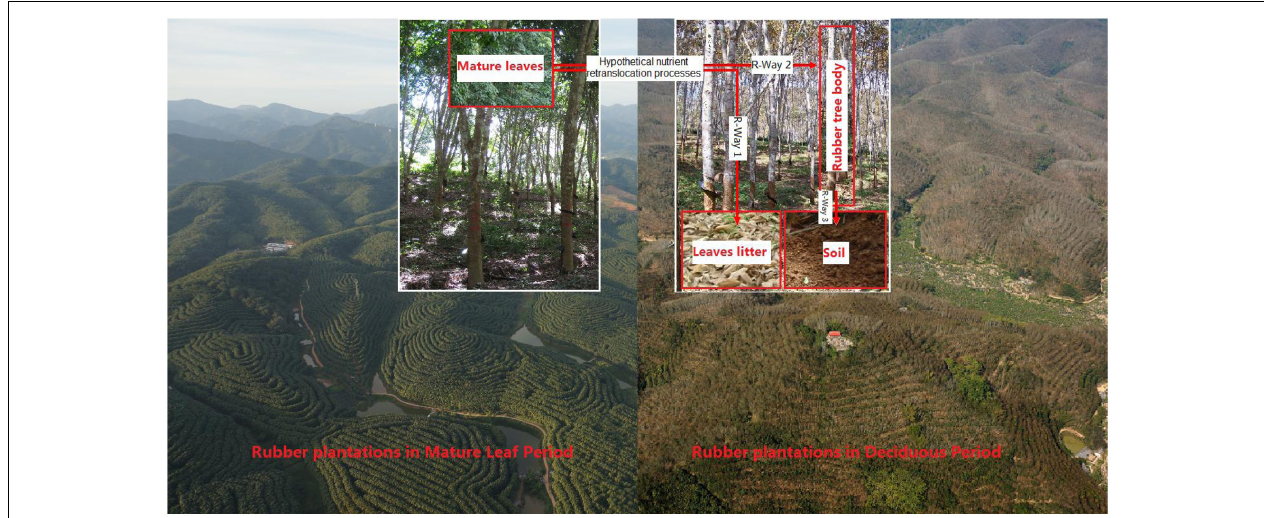
FIGURE 1 | Schematic diagram of the hypothetical nutrient retranslocation processes of rubber trees from mature leaf period to deciduous leaf period.